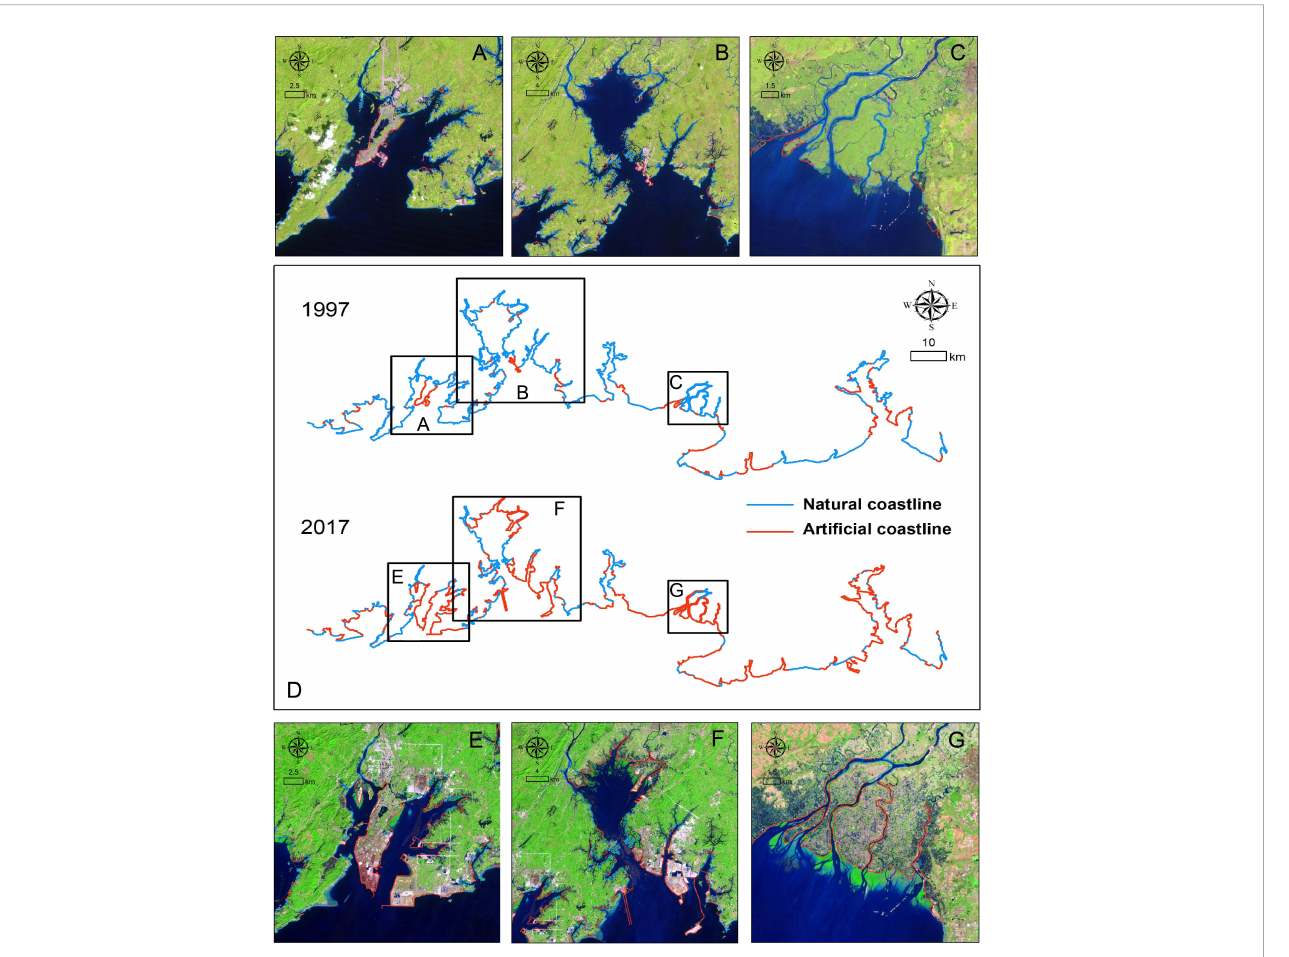
FIGURE 6 Spatio-temporal changes of the coastline in the Guangxi Beibu Gulf in 1997 and 2017 (D) . The natural coast has been reclaimed throughout the entire gulf, where three regions have undergone great changes that were recorded by remote sensing observation, including: remote sensing images of Fangcheng Bay in 1997 (A) and 2017 (E) ; remote sensing images of Qinzhou Bay in 1997 (B) and 2017 (F) ; and remote sensing images of Nanliu River estuary in 1997 (C) and 2017 (G) .